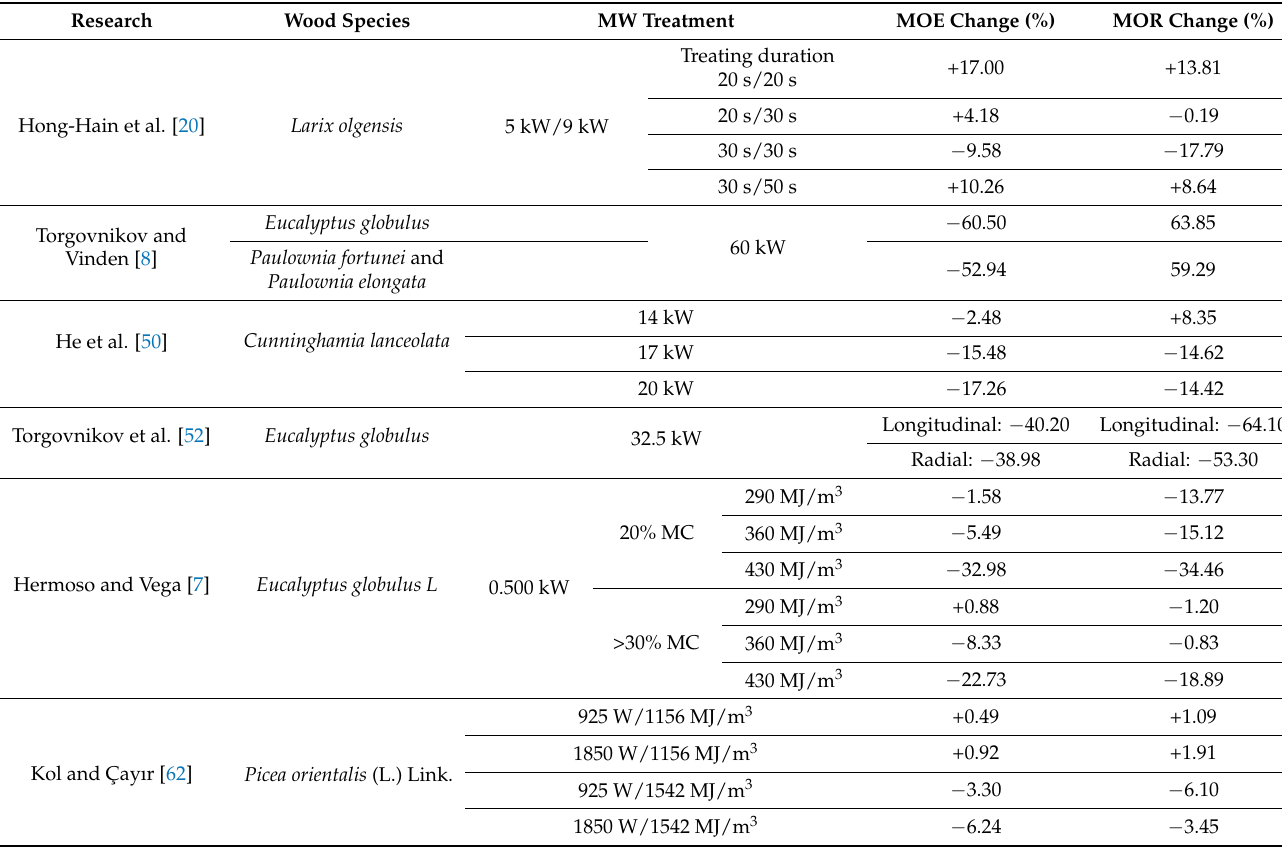
Table 14. Summary of changes in MOE and MOR for increasing wood permeability with MW treatment.